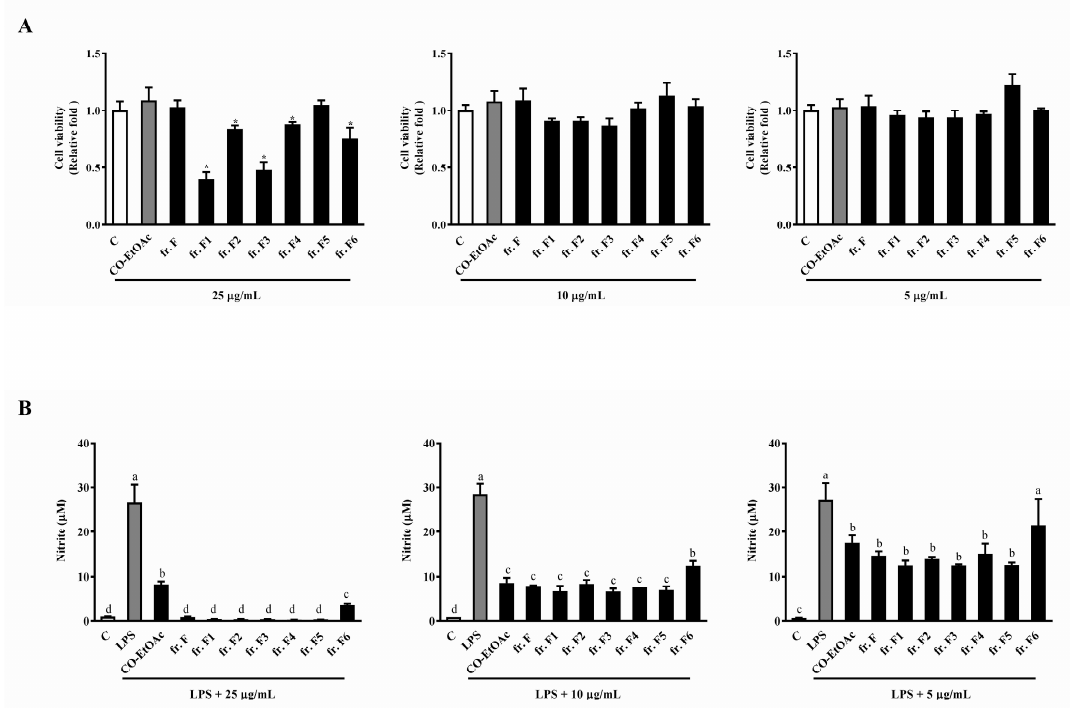
Figure 4. The effects of the subfractions from fr. F (with different concentrations) on cell viability and NO production in RAW264.7 cells. RAW264.7 cells were treated with various concentrations of CO-EtOAc (5, 10, and 25 μ g/mL) in the presence or absence of LPS (1 μ g/mL) for 24 h. ( A ) Cell viability was measured using the WST-1 assay, and the ( B ) NO production in cell culture supernatants determined using the Griess assay. The results are expressed as means ± SD from three independent experiments. For cell viability: * indicates p < 0.05 when compared to the DMSO control group. For NO production: values with different letters indicate significant difference ( p < 0.05).